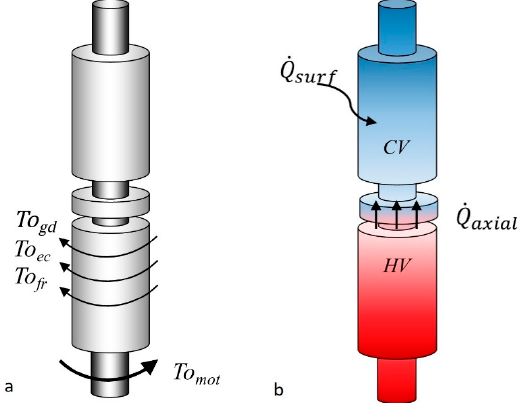
Figure 2. Representation of the mechanical model ( a ) and the thermal model ( b ).